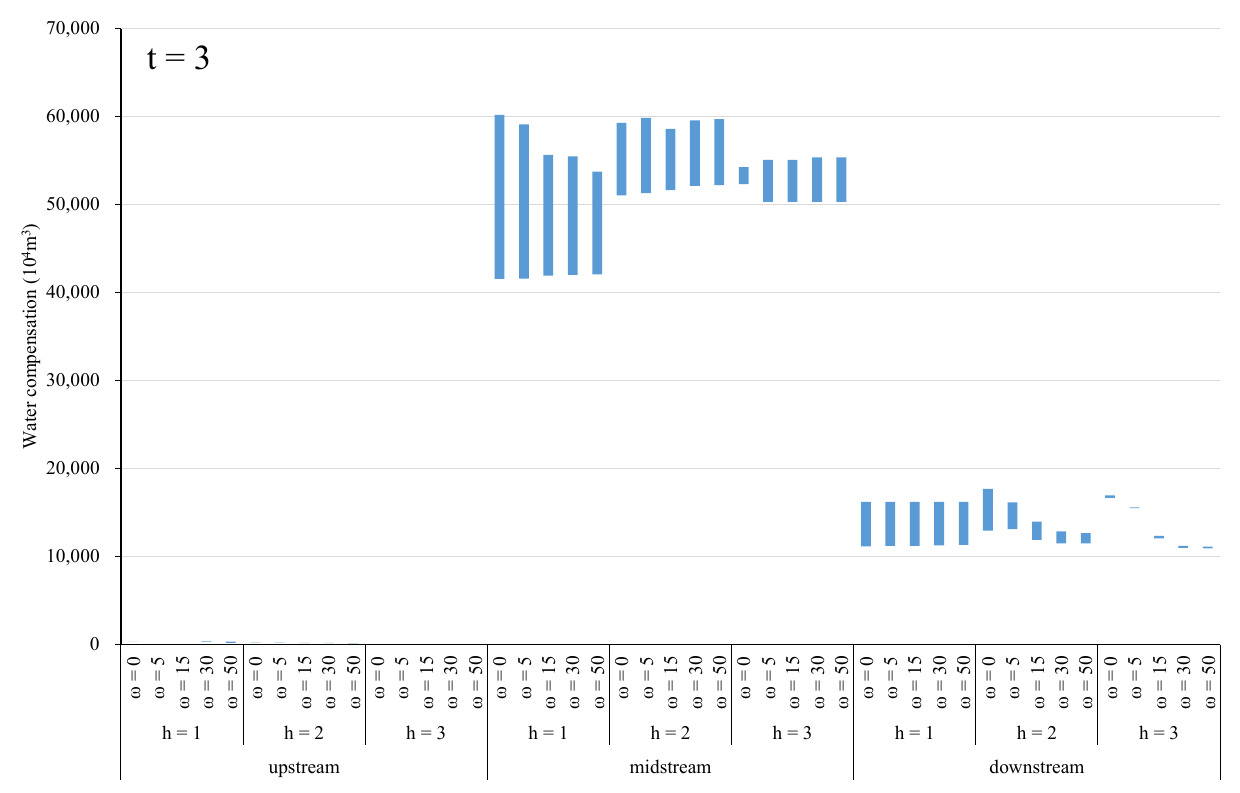
Figure 7. Water compensation by region in the Fenhe River Basin in period 3.